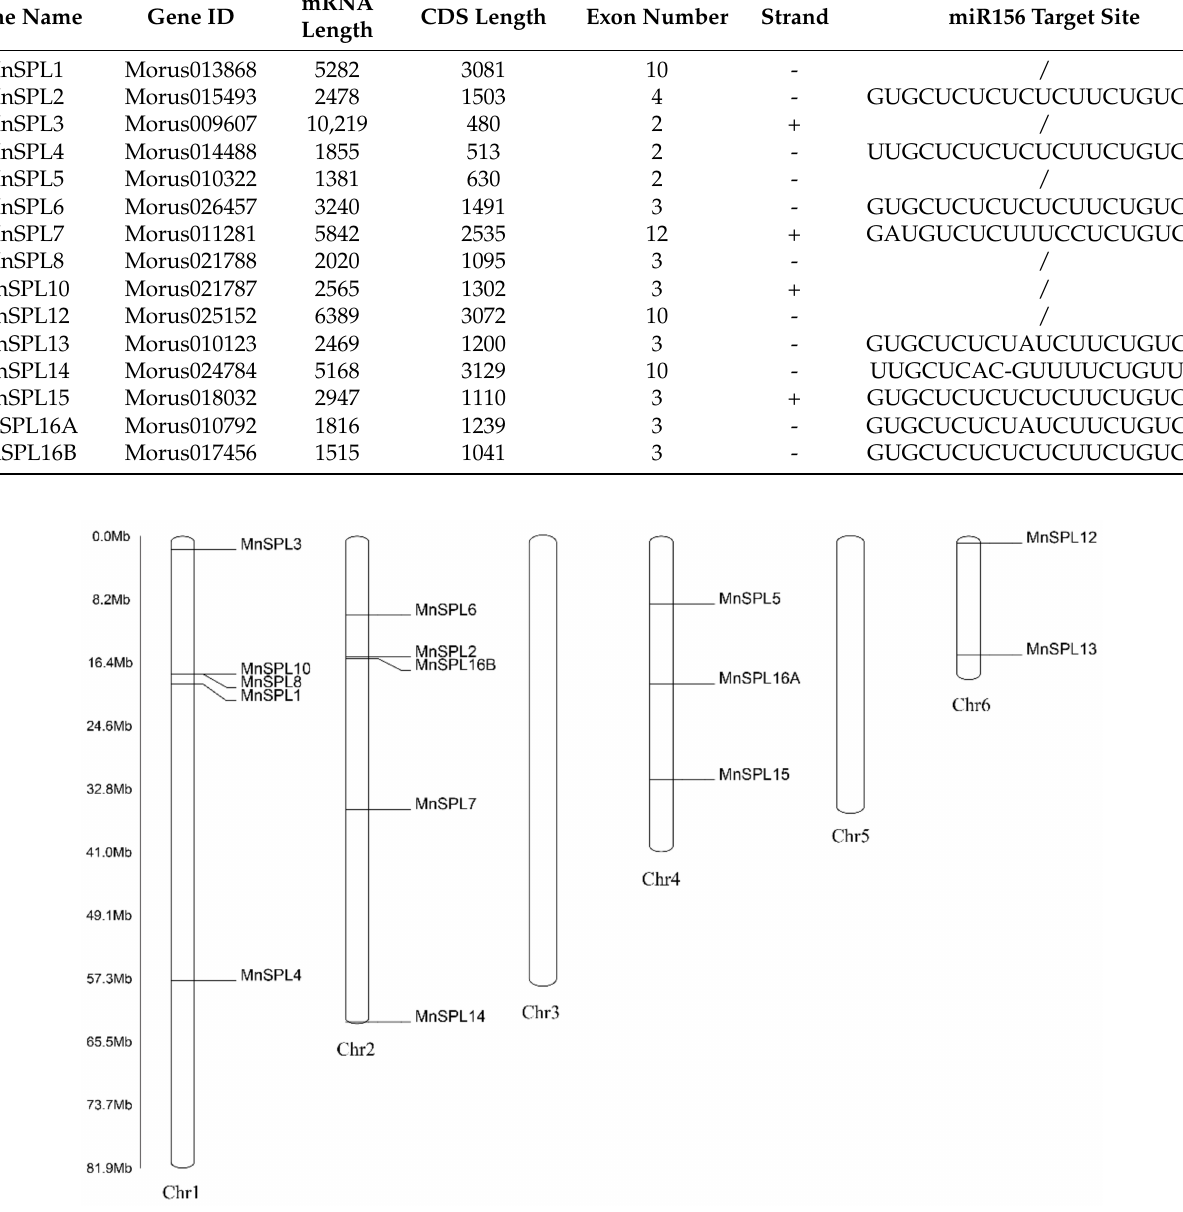
Figure 1. Distribution of SPL genes in the mulberry genome. The scale is presented on the left. To investigate the evolutionary relationships of SPL genes in plants, we collected a dataset of 104 putative SPL protein sequences, including 18 from rice, 16 from Arabidopsis , 28 from poplar, 27 from apple, and 15 from mulberry, for a phylogenetic analysis with a neighbor-joining (NJ) phylogenetic tree. The result of phylogenetic analysis showed that these 104 SPL genes were relatively evenly clustered into 5 groups (G1–G5) and each group contained at last 1 SPL protein from these 5 species. However, MnSPLs had proximate relationships to MdSPLs and outermost relationships to SPLs from rice (Figure 2). These results suggest that plant SPL genes may have originated from common ancestral genes, but some SPL genes may have been differentiated separately between monocots and